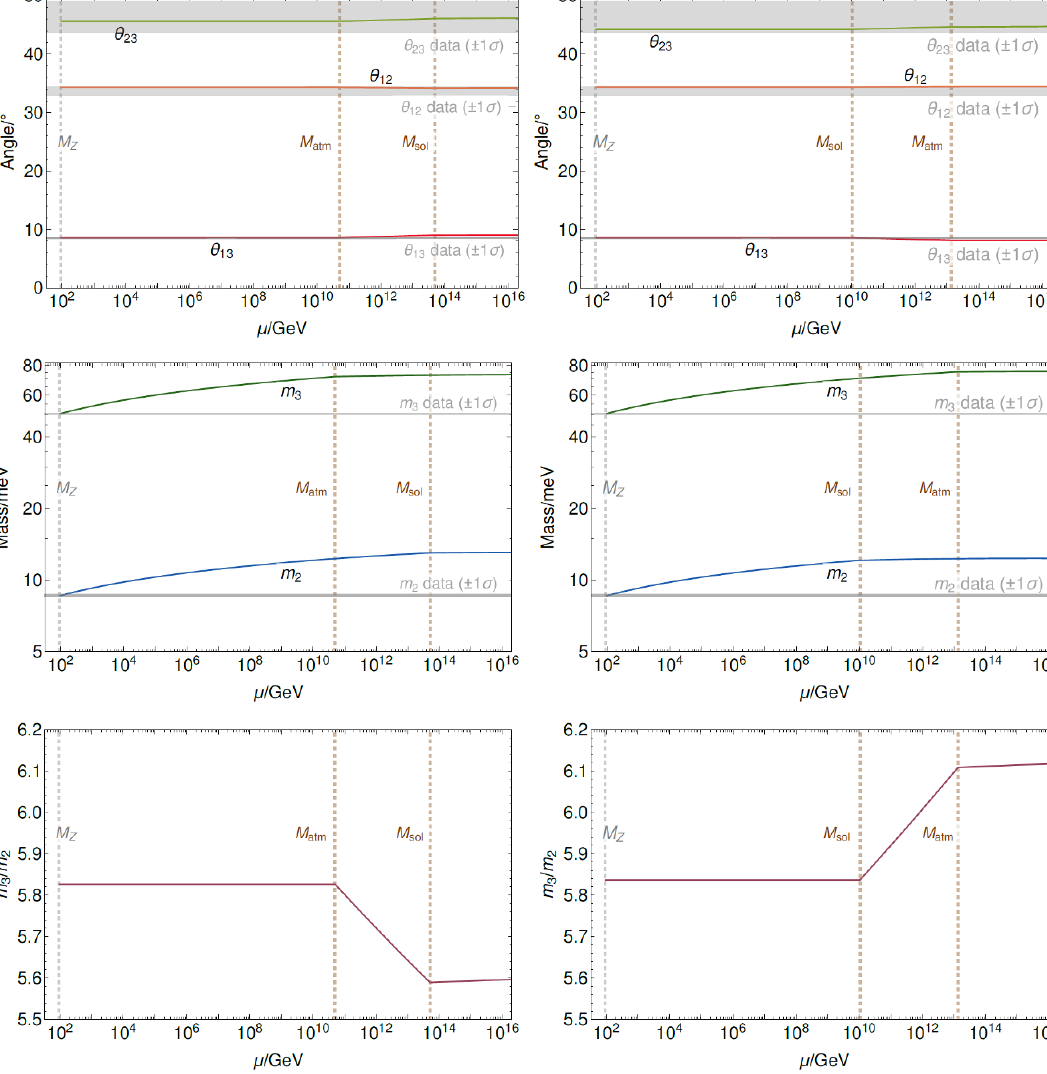
Figure 3 . Running of neutrino observables. Case A2 results are shown on the left which can be compared with Case D2 on the right. Recalling that m 1 = 0, we have converted 1 (cid:27) limits on (cid:1) m 2 and (cid:1) m 2 into limits on the m 2 and m 3 mass 12 13